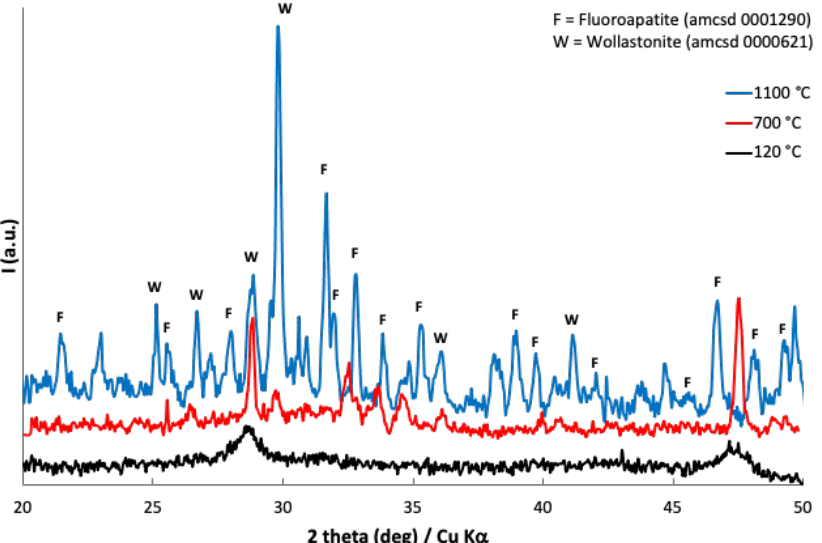
Figure 1. Powder X-ray patterns of Mn-doped bioactive glass-ceramic as obtained at 120 °C (black line, below), after treatment at 700 °C (red line, middle), and at 1100 °C (blue line, above).